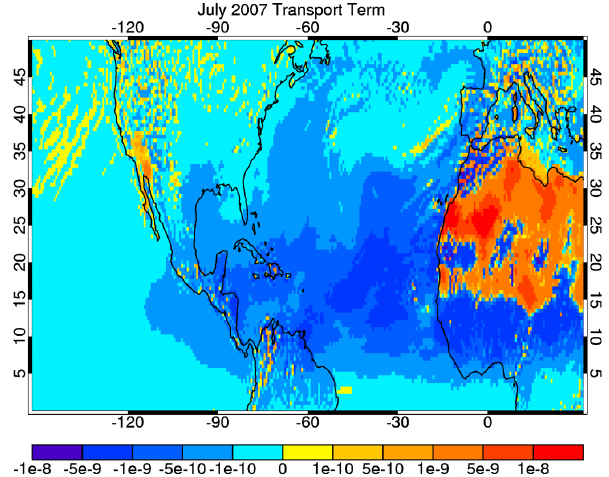
Fig. 12. July 2007 production minus loss (P-L) term (kgm − 2 s − 1 ) as described in Sect.